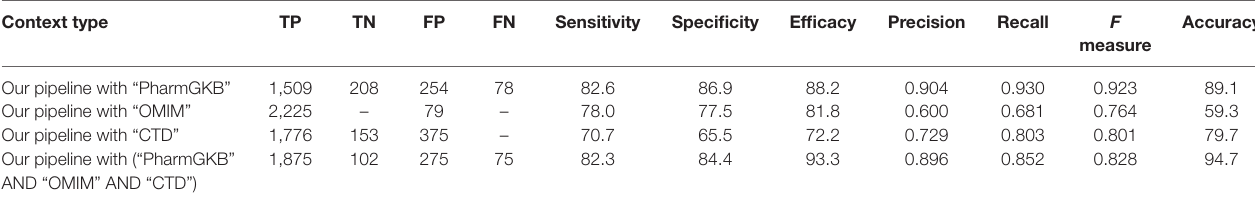
TABLE 1 | Performance comparison of pharmacogenomic (PGx) relationships obtained from our proposed pipeline with other benchmark datasets (OMIM, CTD, and PharmGKB). Context